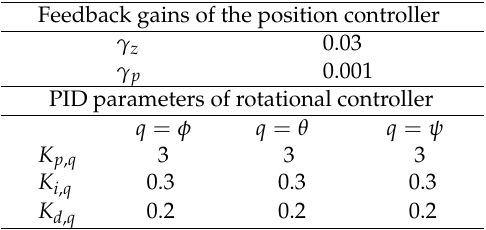
Table 1. Feedback gains of the position and the rotational